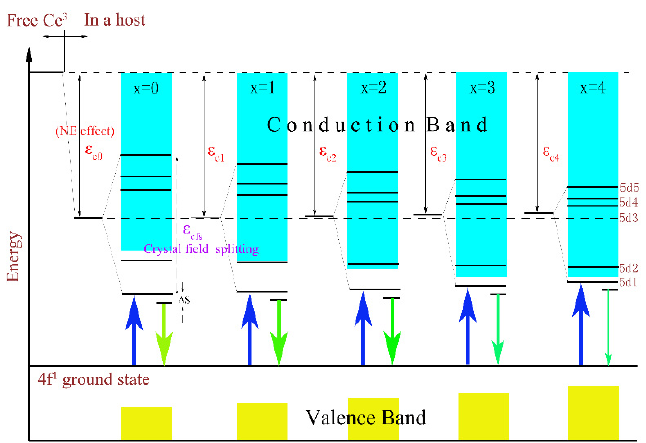
Figure 5. The effects of CFS and NE on the energy levels of the Lu 2.94 Ga x Al 5 − x O 12 : 0.06Ce 3+ (x = 0, 1, 2, 3, 4) phosphors and its ionization processes.